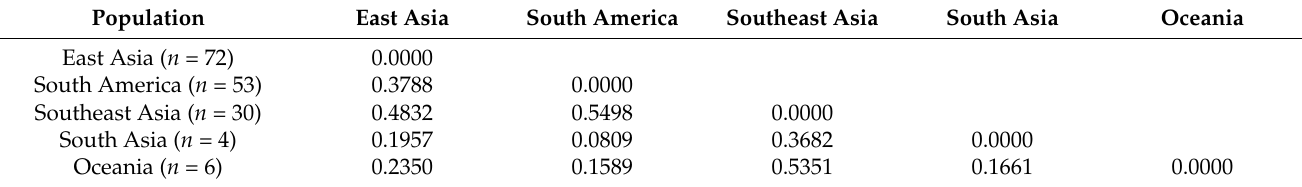
Table 5. Estimation of genetic differentiation (F ST *) of the pvmrp1 among geographical